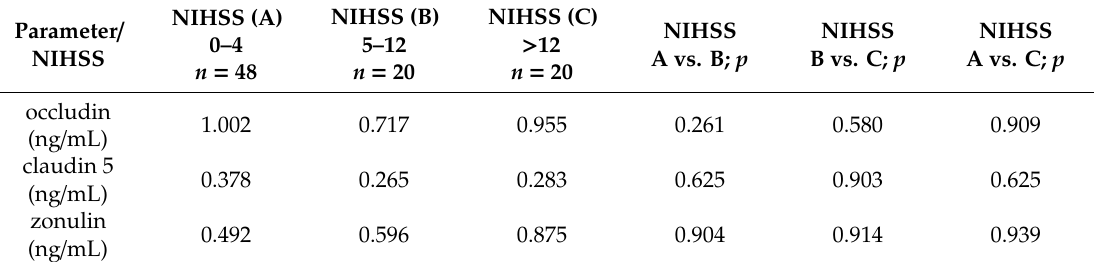
Table 4. The comparison of mean concentrations of occludin, claudin 5, and ZO-1 in subgroups of